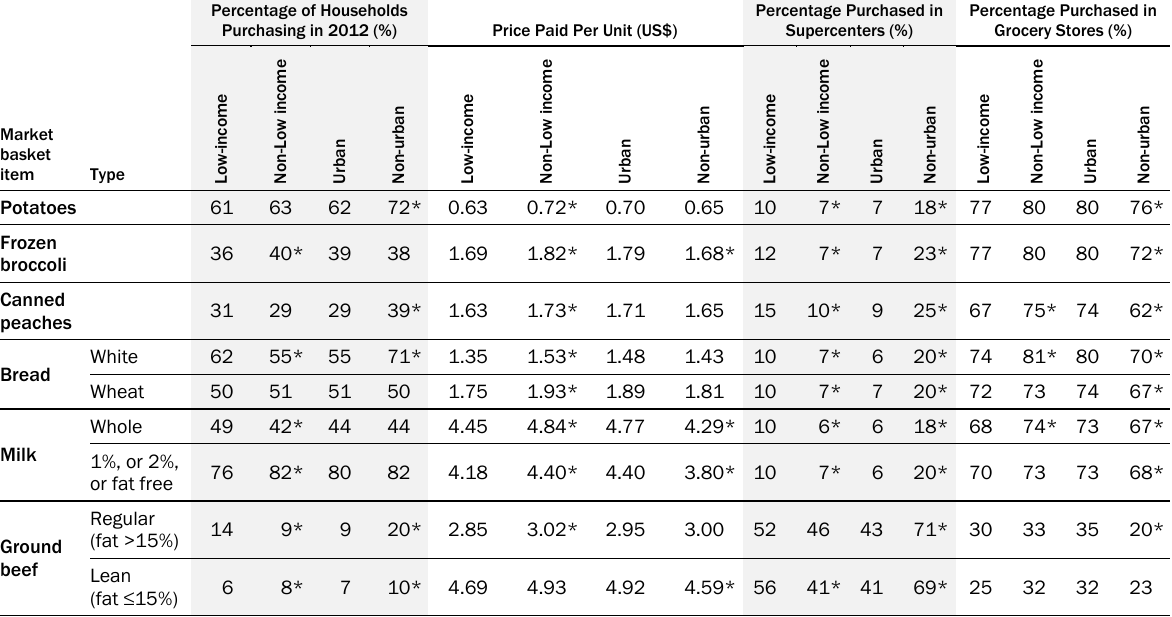
Table 5. Purchasing Patterns of Market Basket Items in the Northeast IRI Consumer Network Panel Sample, by Income and Rural/Urban